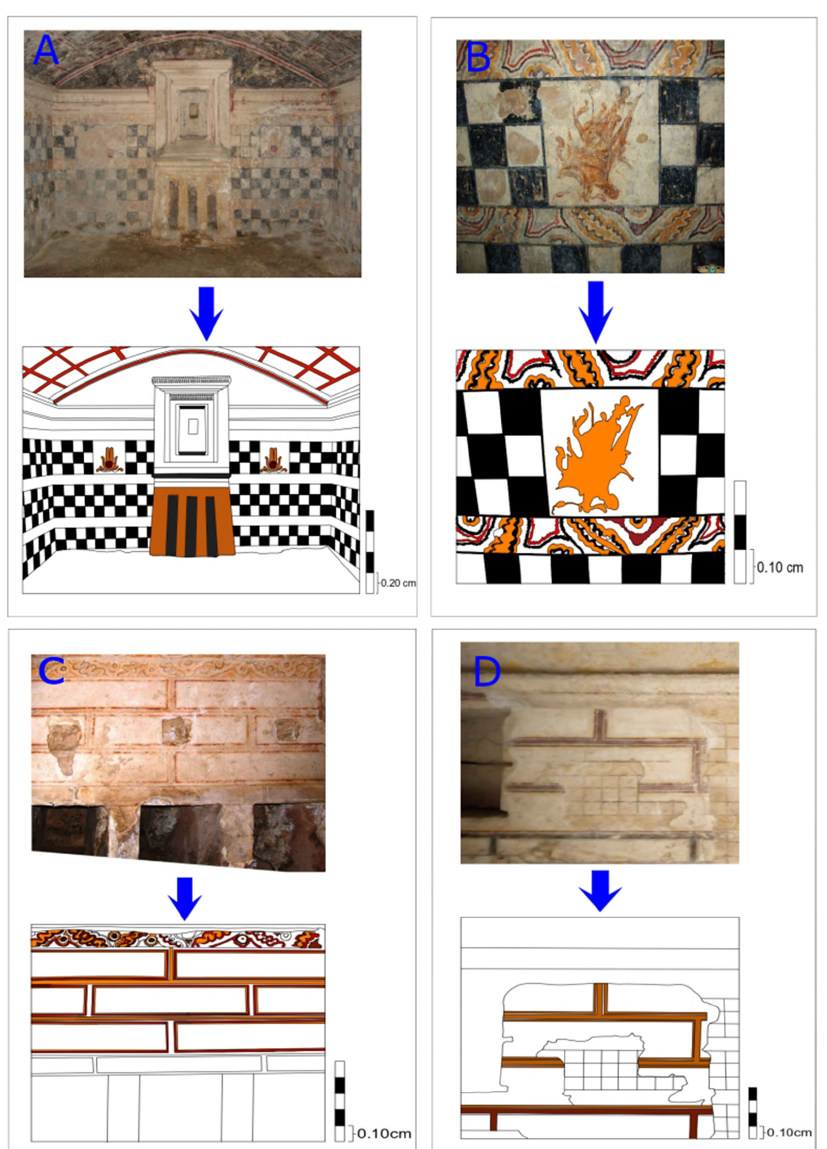
Figure 20. ( A – D ) Digital restoration of some selected structural and architectural elements in Anfushi’s Necropolis (walls of tomb No 2, rooms 1 and 2) using AutoCAD 2020.